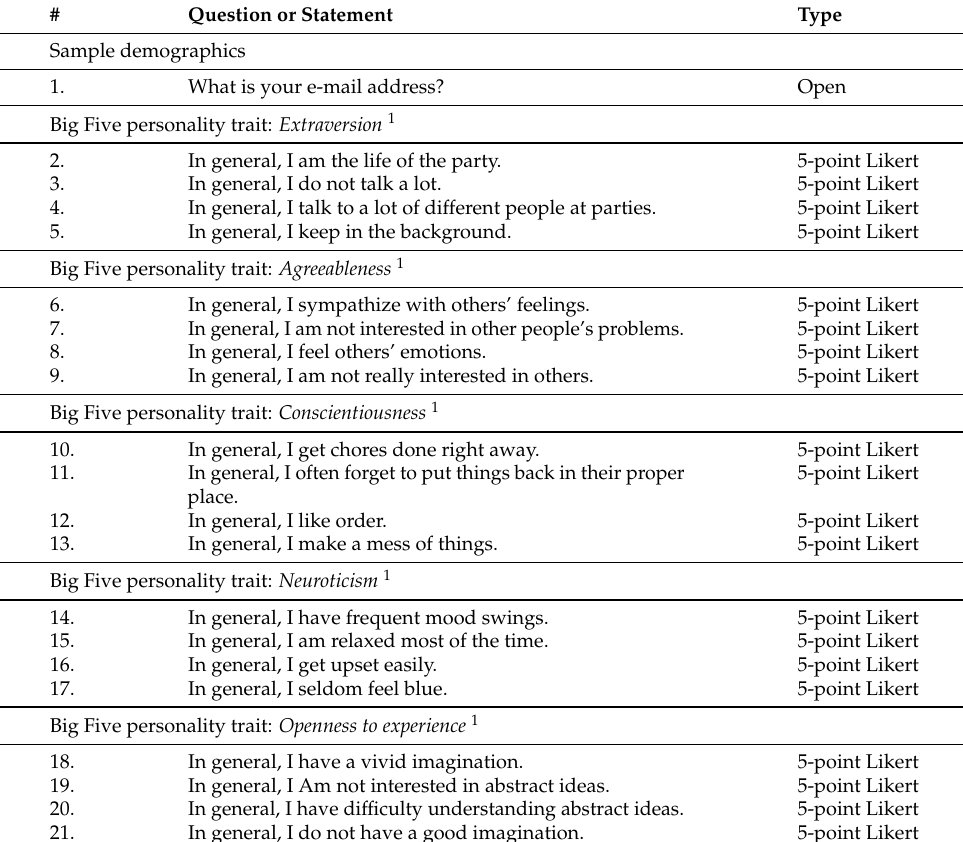
Table A3. Details of pre-test